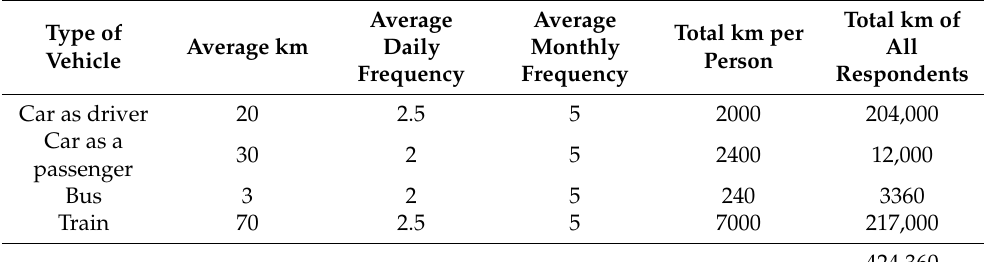
Table 7. Total km for teaching and administrative staff by mode of transport in